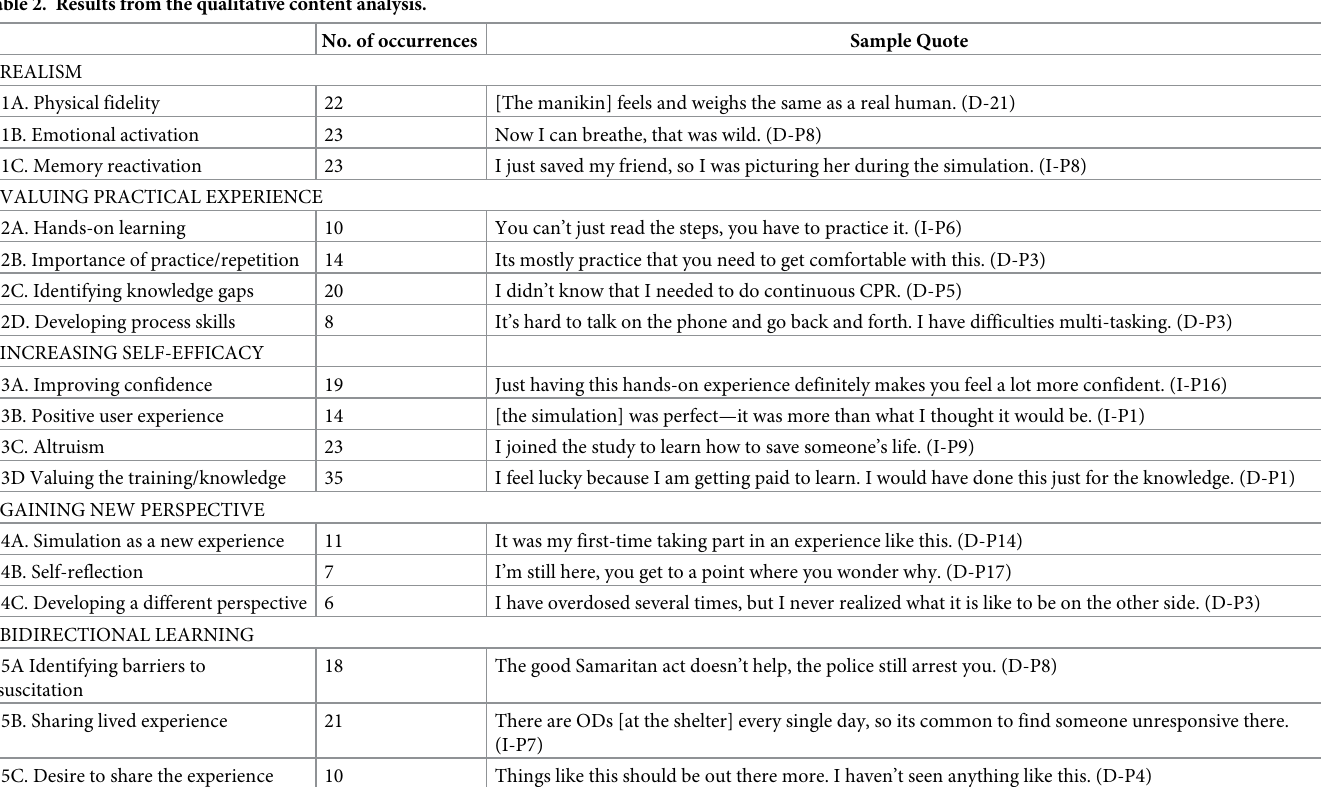
Table 2. Results from the qualitative content